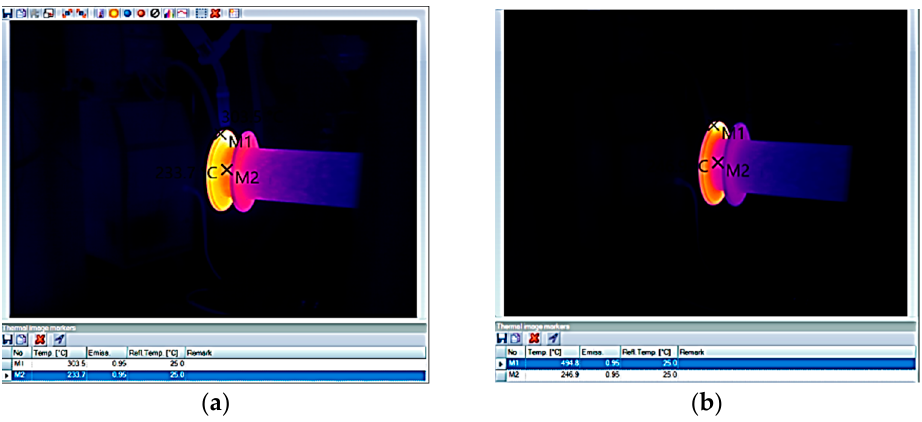
Figure 5. Thermography of the weld seam at the diameter of 195 mm, layer no. 15. Before welding ( a ) and after welding ( b ).